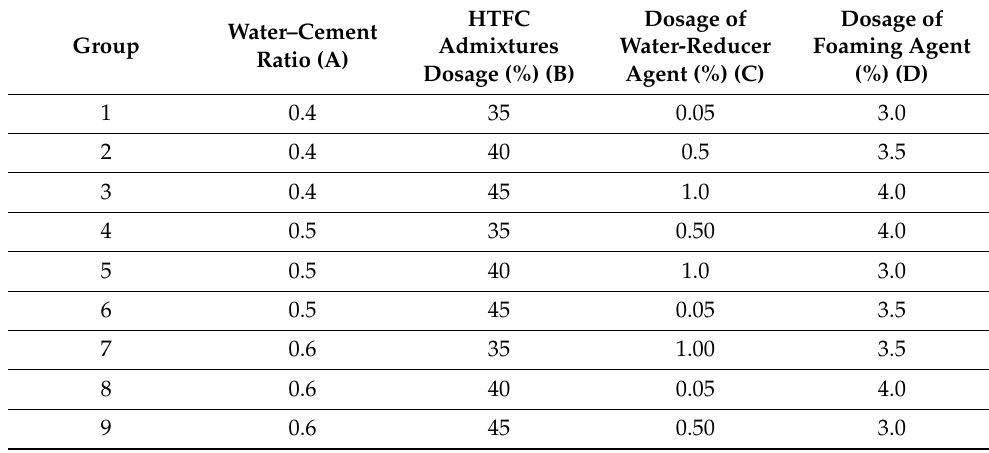
Table 5. Orthogonal-test table.